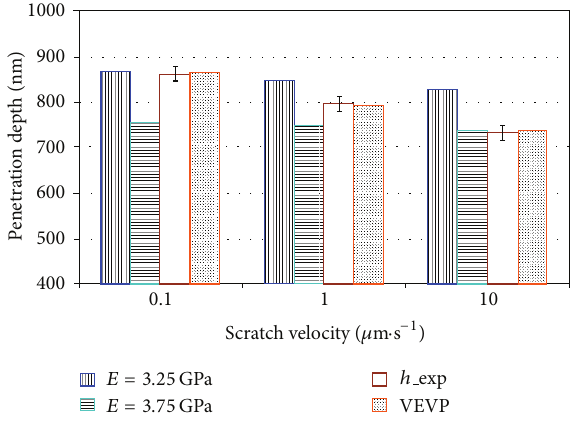
Figure 15: Comparison of experimental results ( ℎ exp) and numer- ical results (elastic-viscoplastic and viscoelastic-viscoplastic) for = 20 mN. The data denoted by 𝐸 = 3.25 GPa (resp., 𝐸 = 𝐹 𝑛 3.75 GPa) are those calculated with the elastic-viscoplastic model in using a Young modulus of 3.25 GPa (resp., 3.75 GPa). The data denoted VEVP corresponds to the viscoelastic-viscoplastic model.